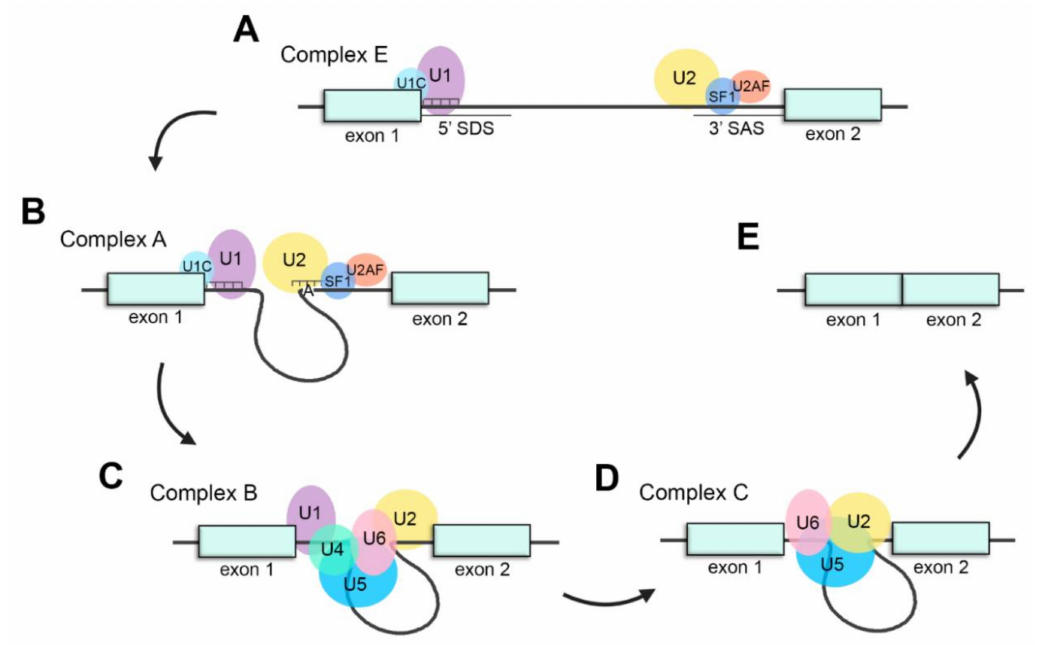
Figure 2. Schematic representation of the splicing process. ( A ) Assembly of the spliceosome: U1 snRNP recognizes the splice donor site (SDS) and U2 snRNP recognizes the splice acceptor site (SAS) to generate complex E. ( B ) U2 recognizes the adenosine at the branch-site and forms complex A. ( C ) The U4/U6 · U5 tri-snRNP joins the spliceosome to form complex B. ( D ) U4 and U1 are released, U6 replaces U1 recognizing the SDS and interacts with U2, generating complex C and catalyzing the splicing reaction. ( E ) Exons are ligated, and intronic pre-mRNA and spliceosomal snRNPs are